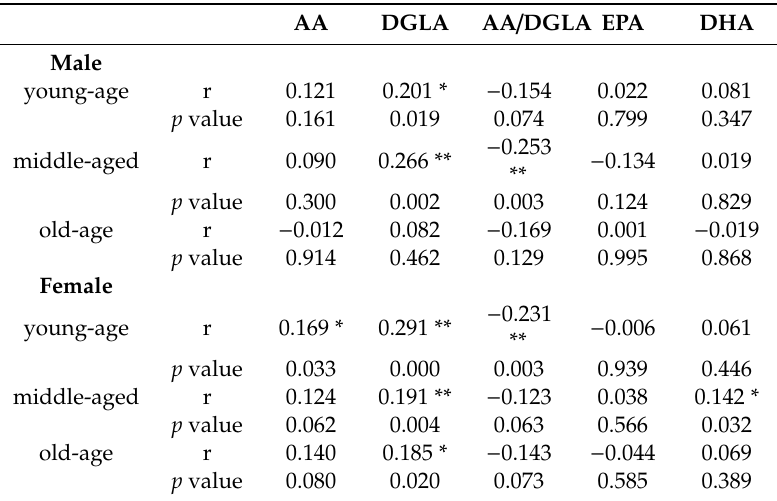
Table 3. Relationship between SROS and PUFAs (Correlation coe ffi cient).